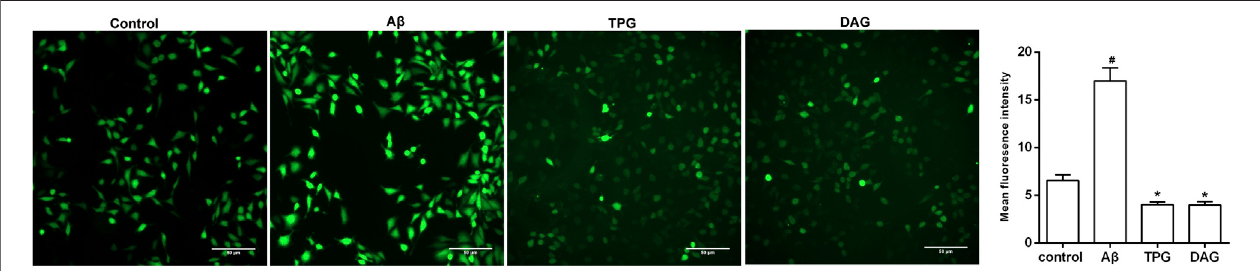
FIGURE 5 | The regulation of TPG and DAG on the intracellular ROS in A β 25 – 35 -exposed cells. The intracellular ROS level was recorded by fl uorescence microscope with DCFH-DA. The intracellular ROS level in different groups after being induced with A β 25 – 35 or treated with thetwogelatins. Scale bars: 50 μ m. All values